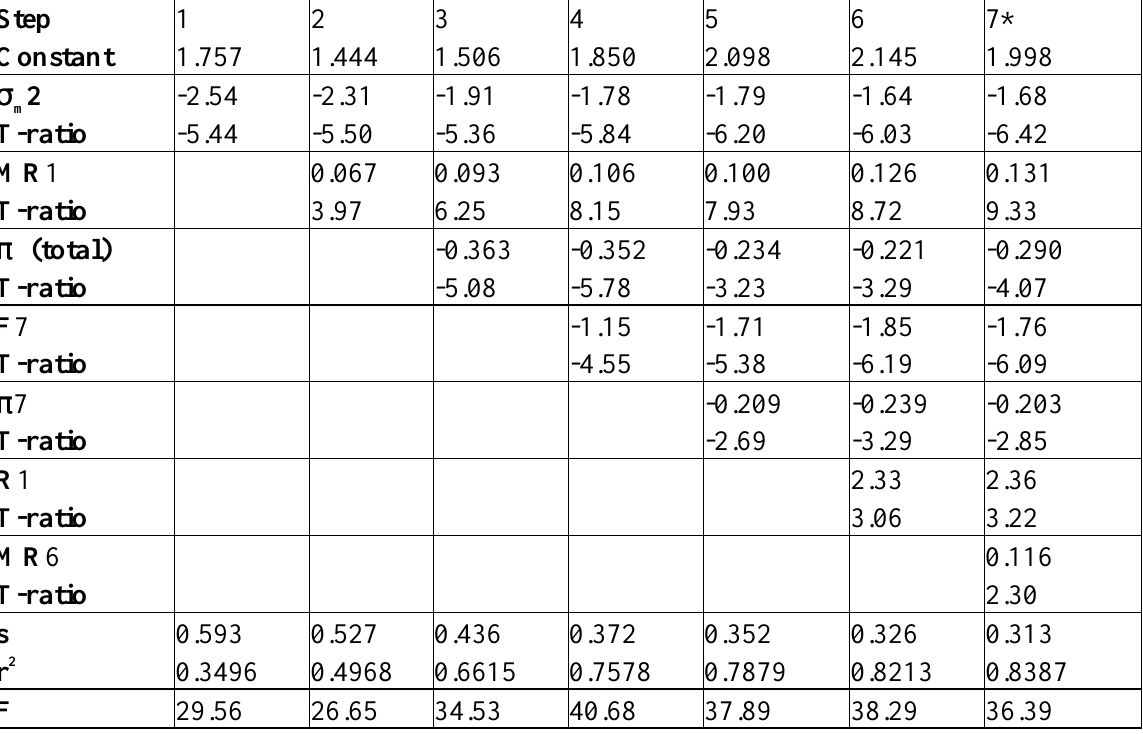
Table 5. Stepwise regression of logIC